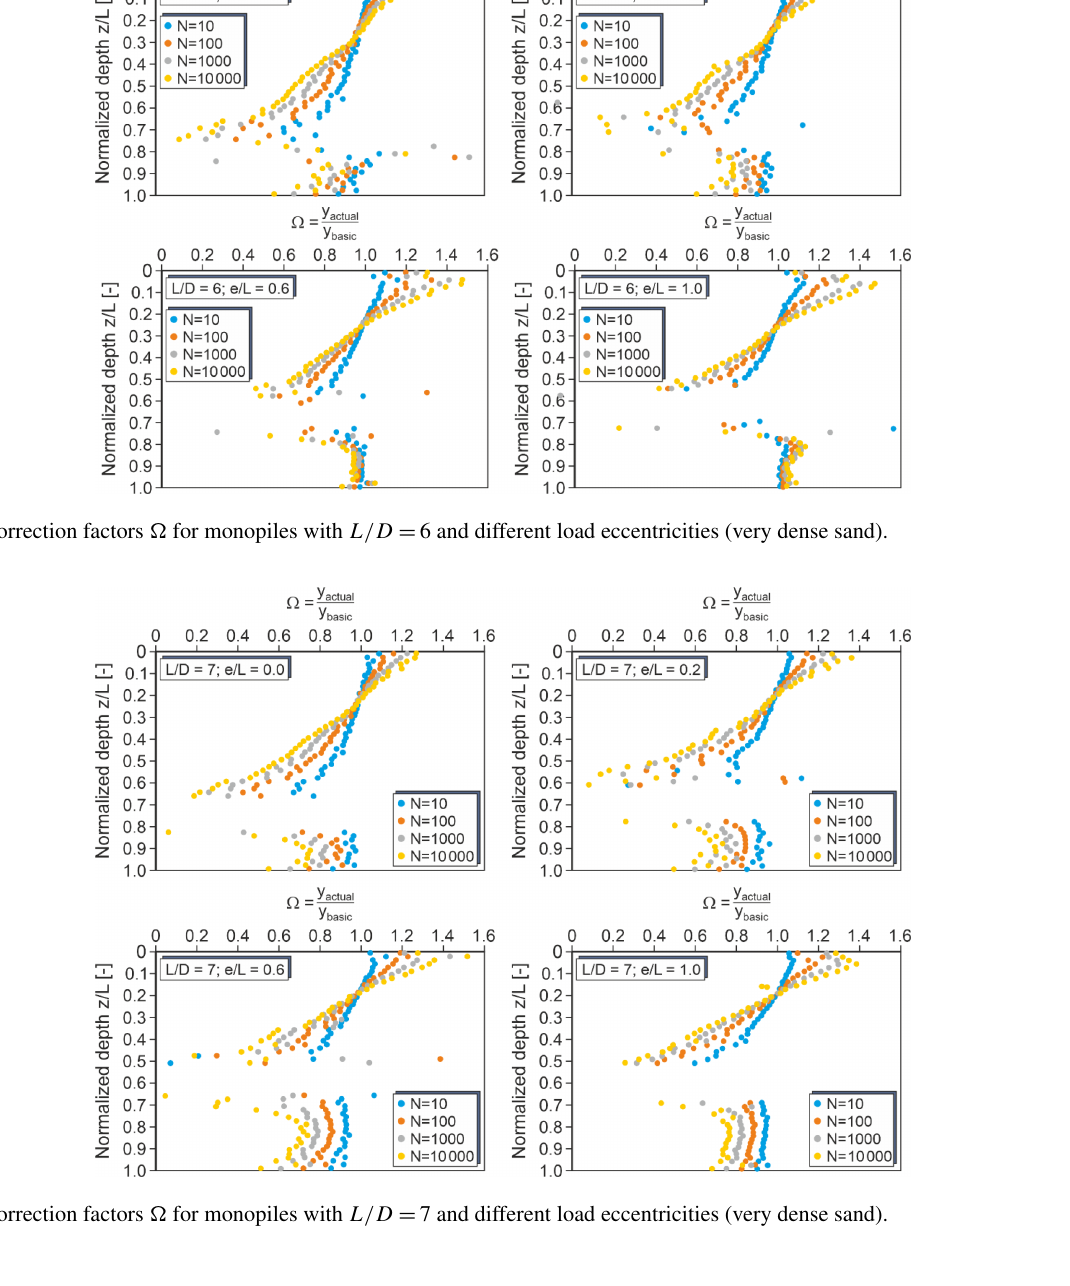
stant values below the rotation point decrease slightly with increasing L/D